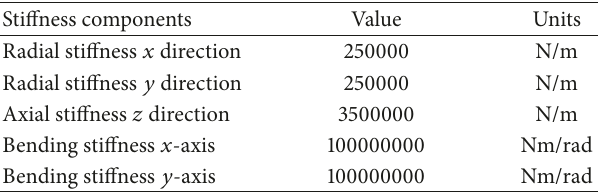
Table 2: Stiffness of the rubber elements located at the top of the spring.